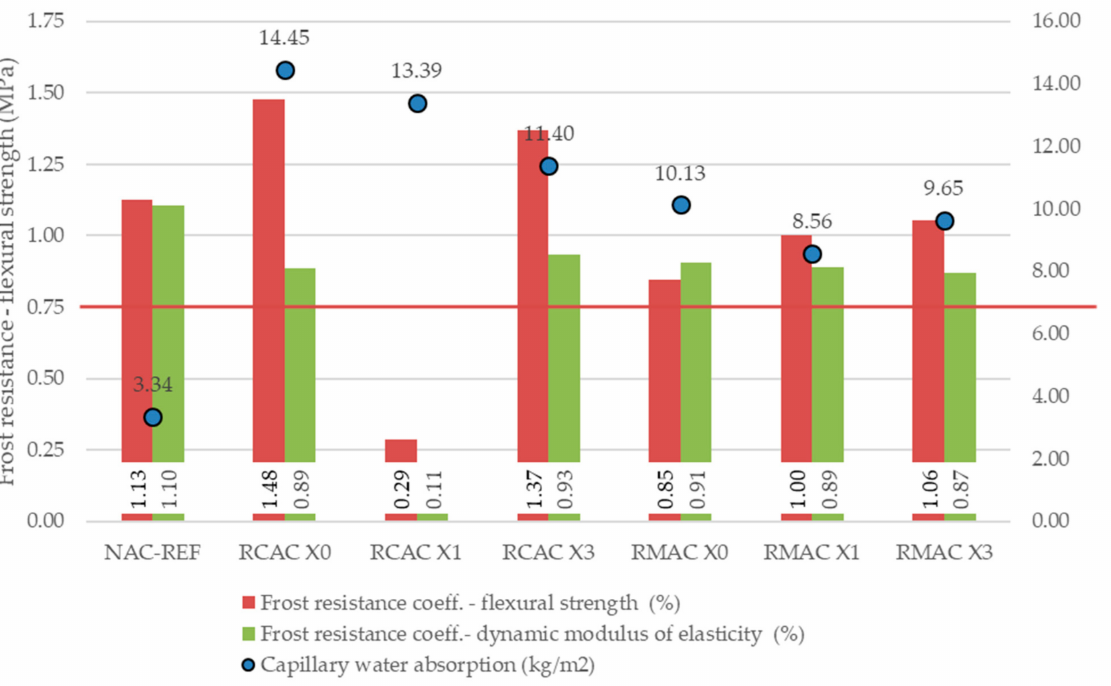
Figure 7. Frost resistance coefficient and capillary water